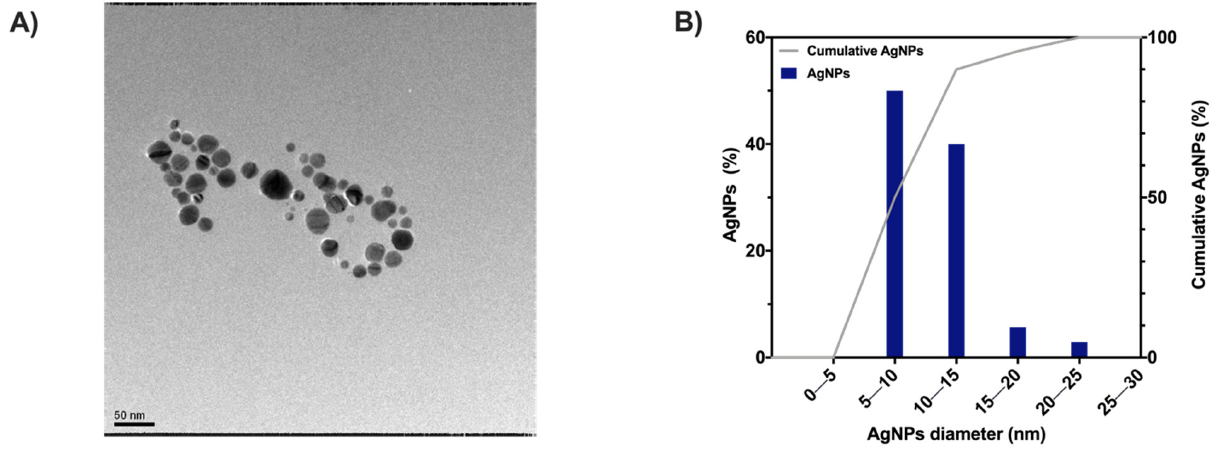
Figure 6. ( A ) TEM image of MC/AgNPs solution and ( B ) MC/AgNPs distribution analysis.